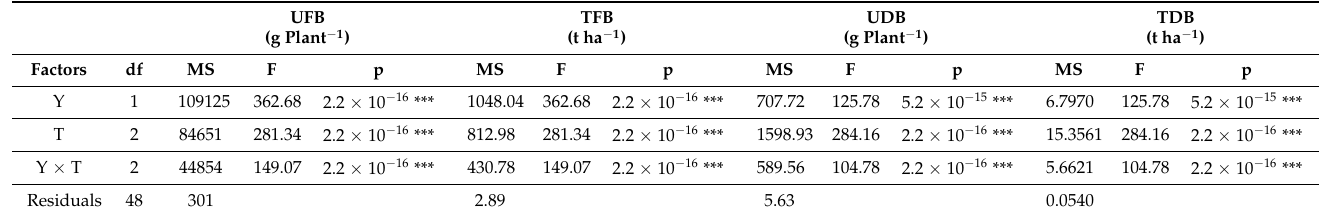
Table 4. Analysis of variance (ANOVA) applied to the mixed model.